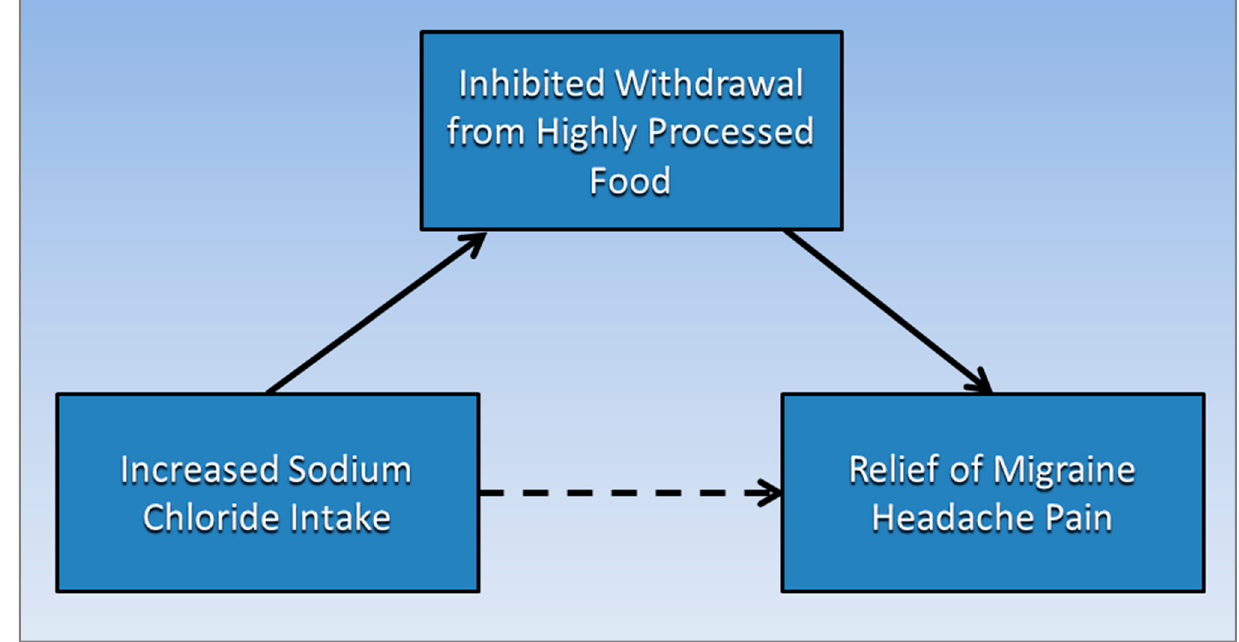
Figure 1. Inhibited withdrawal from highly processed food mediates the association of increased sodium chloride intake levels and the relief from migraine headache pain.